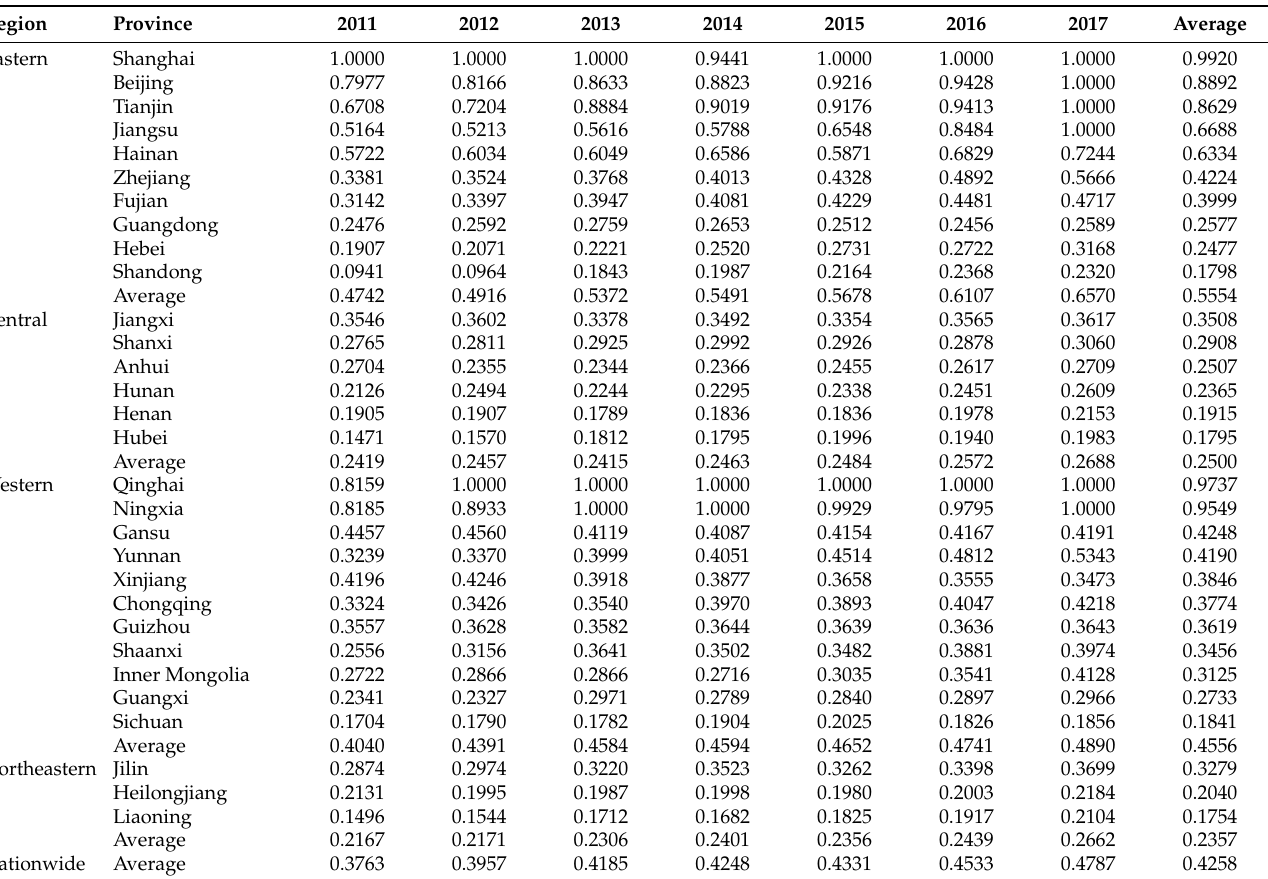
Table 3. SLUE in 30 Chinese provinces from 2011 to